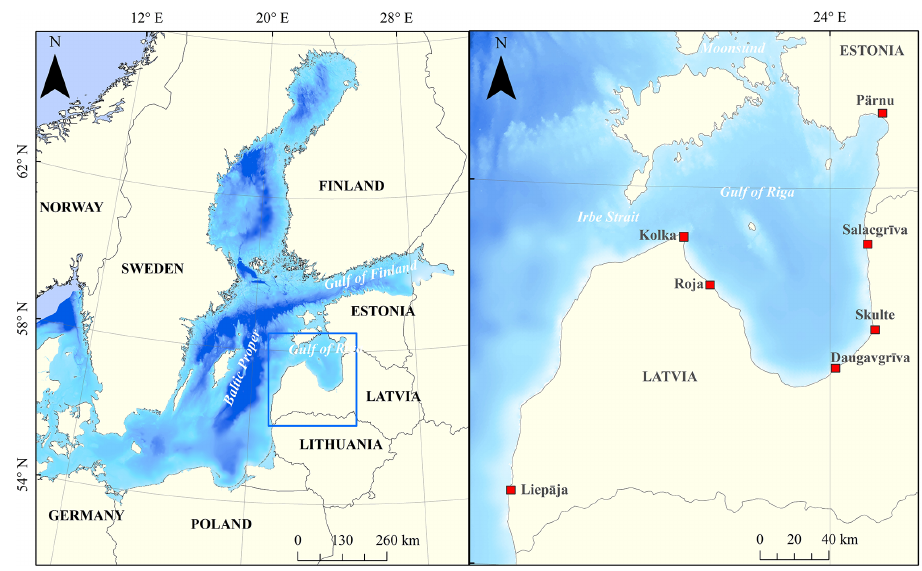
Figure 1. Analyzed water level measurement sites (red rectangles) in the Gulf of Riga and on the Baltic-proper shores of